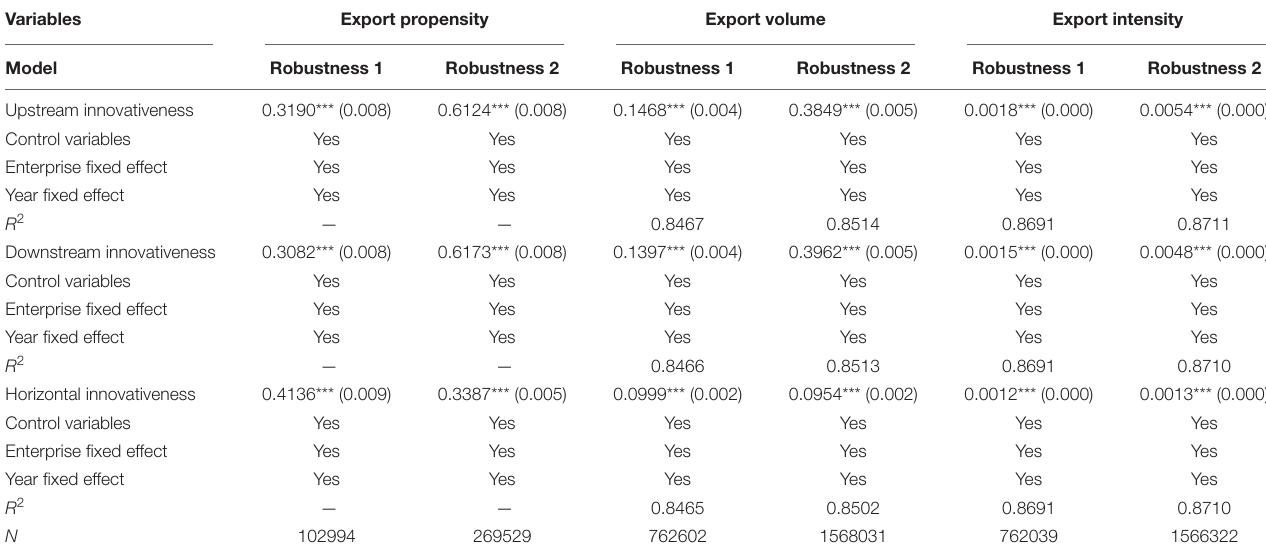
TABLE 2 | Robustness